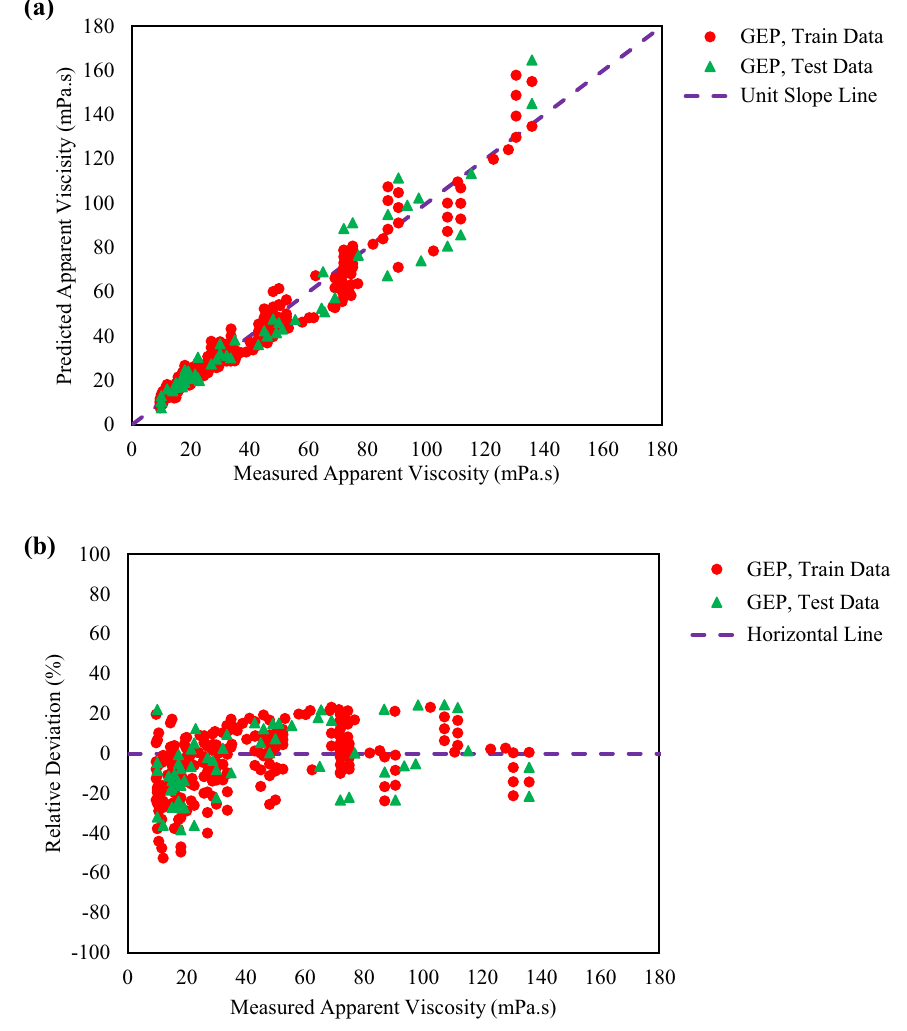
Fig. 5 a The cross plot and b the relative deviation plot of the established GEP-based